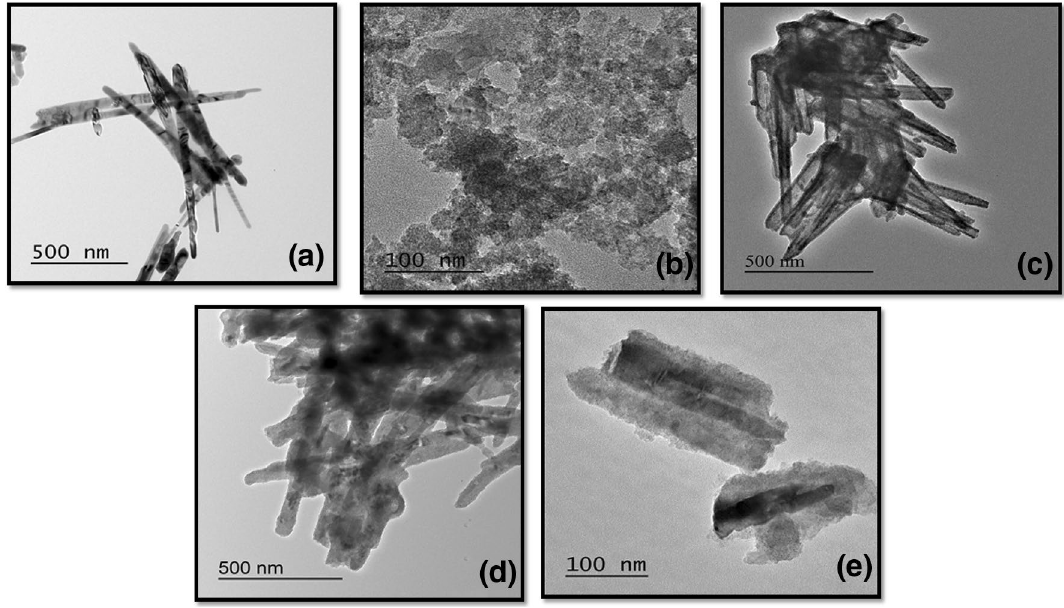
Fig. 2 TEM micrographs for the a Z1, b Z2, c Z3, d Z4 and e